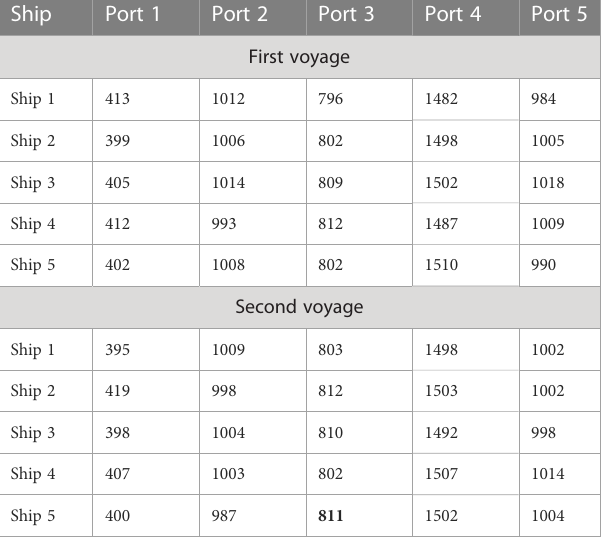
TABLE 2 Container handling numbers at different ports (TEU).